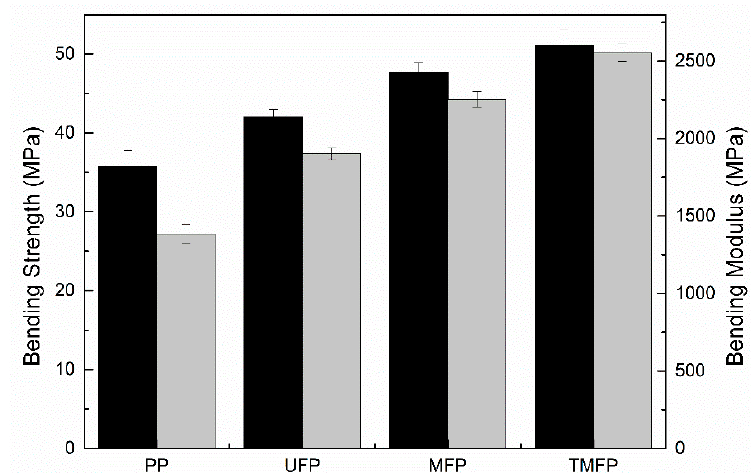
Figure 11. Bending properties of di ff erent PP composites (( a ) PP, ( b ) PP composite filled with untreated PET fiber, ( c ) PP composite filled with the MPP-modified PET fiber, ( d ) PP composite filled with the TMPP-modified PET fiber).